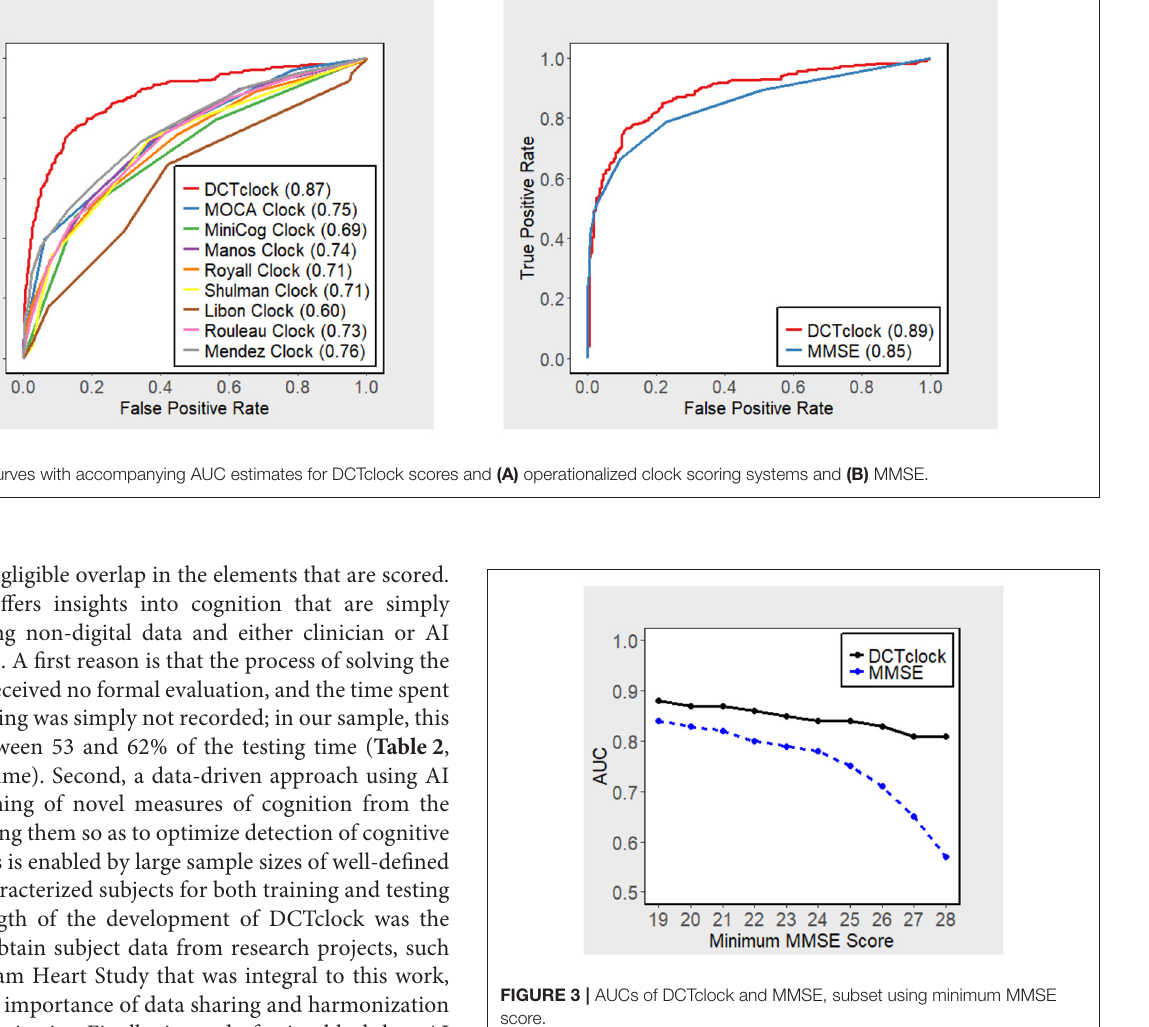
32 s in our cognitively impaired group ( Table 2 , Total